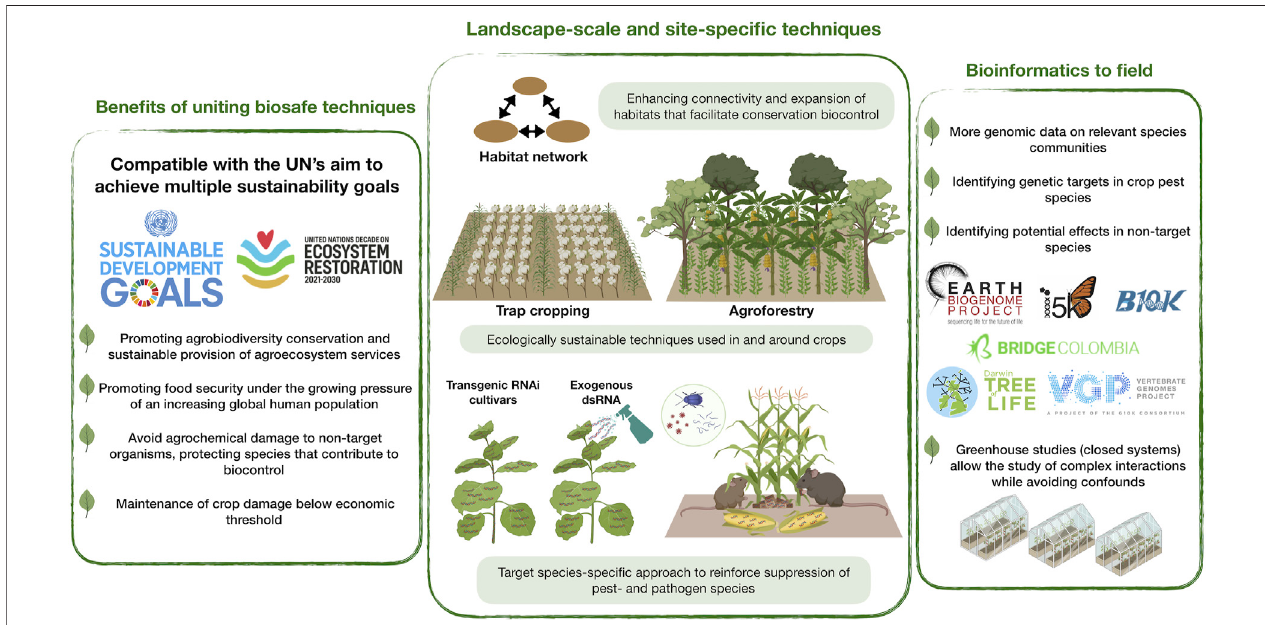
FIGURE1| ConceptualschemeofunitingRNAinterference (RNAi)andconservationbiocontroltosustainglobalfoodsecurityandbiodiversity.Thisaddressesthe United Nation ’ s(UN ’ s)sustainabledevelopmentgoalsandtheUNDecadeonEcosystemRestorationglobal initiative.Thisisenabledbylandscape-scaleconnectivityof habitats, ecologically sustainable interventions in and around crops to support populations of biocontrol agents and biodiversity in general (e.g., trap cropping, agroforestry), and the use of species-speci fi c RNAi approaches (e.g., RNAi cultivars, dsRNA spray). The latter will be supported by the generation of genomic/ transcriptomic data on a wide range of eukaryotic species, including pathogens, animal pests and bene fi cial taxa (e.g., via Earth BioGenome Project and af fi liated projects/initiatives). Studies should begin in lab and greenhouse, eventually to be scaled to fi eld experiments.